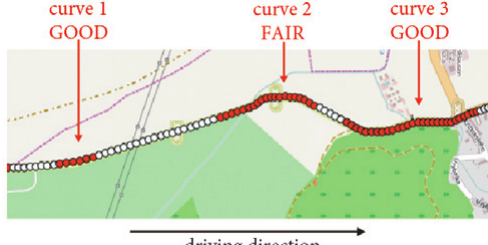
Fig. 9. Assessment of alignment consistency of the three curves